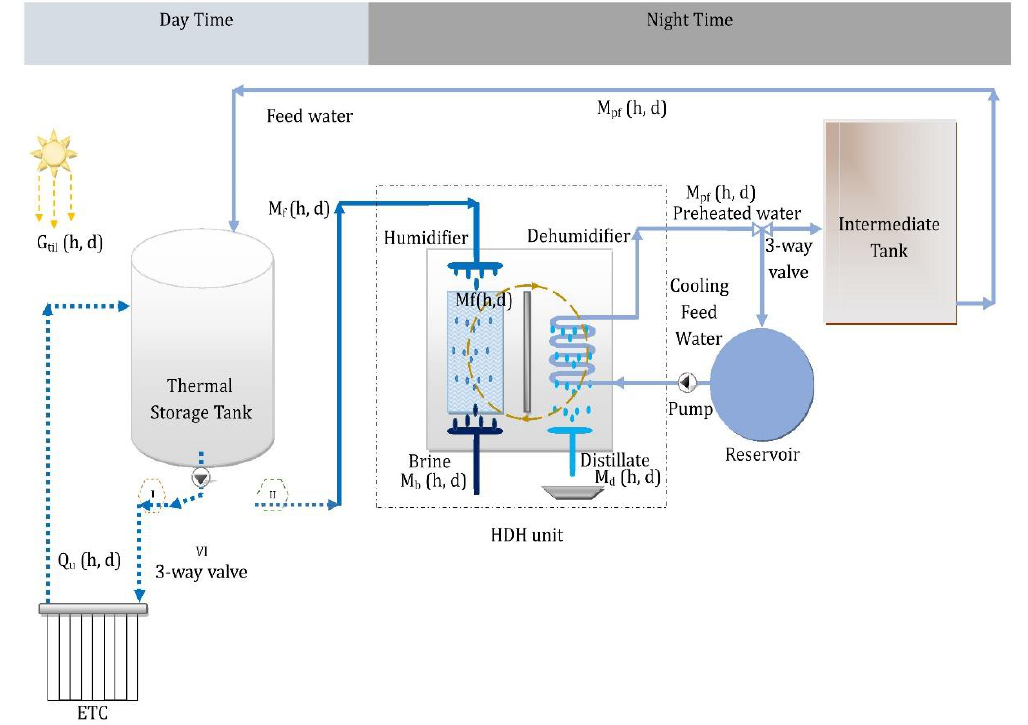
Figure 4. Overall system labeled with key modeling